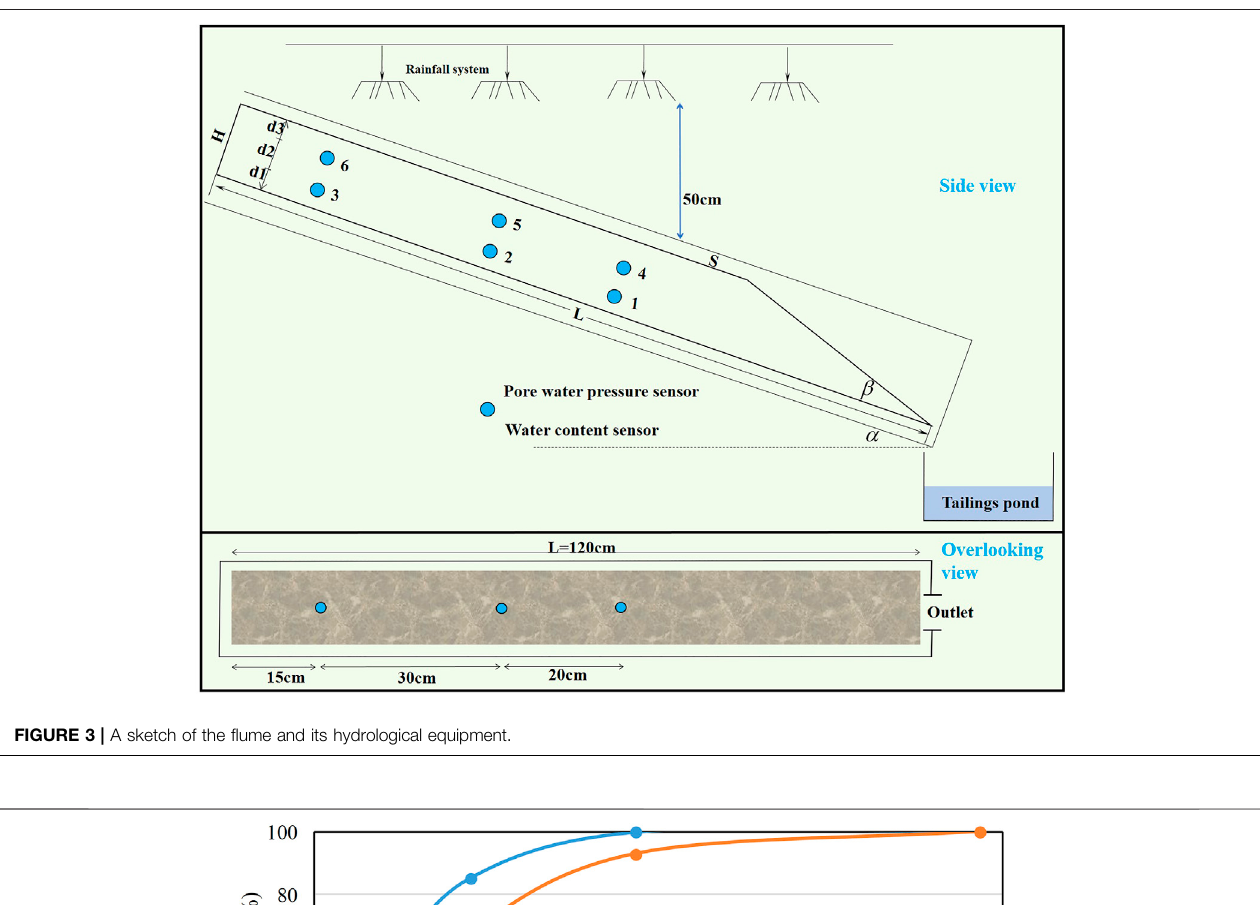
FIGURE 3 | A sketch of the fl ume and its hydrological equipment.